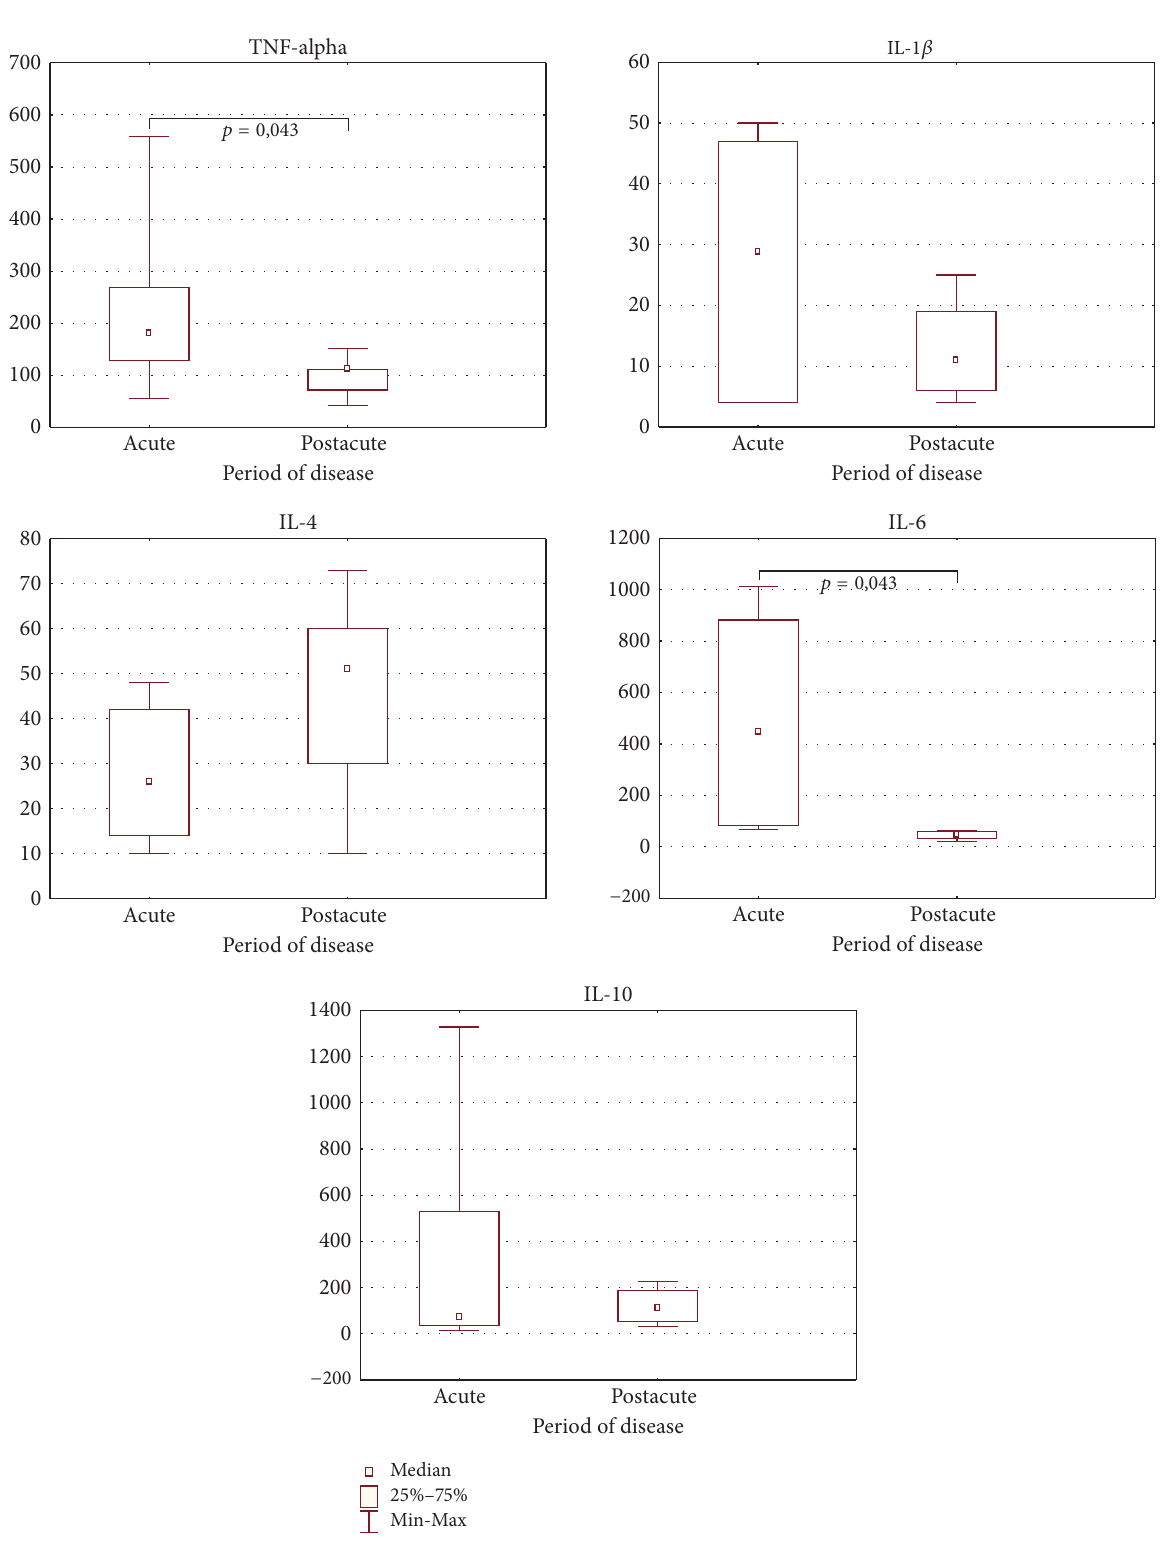
Figure2:Dynamicsofserumcytokinelevels(pg/mL)duringneonatalsepsis(mean;quartilerange). 𝑝 valuewascalculatedbyusingWilcoxon